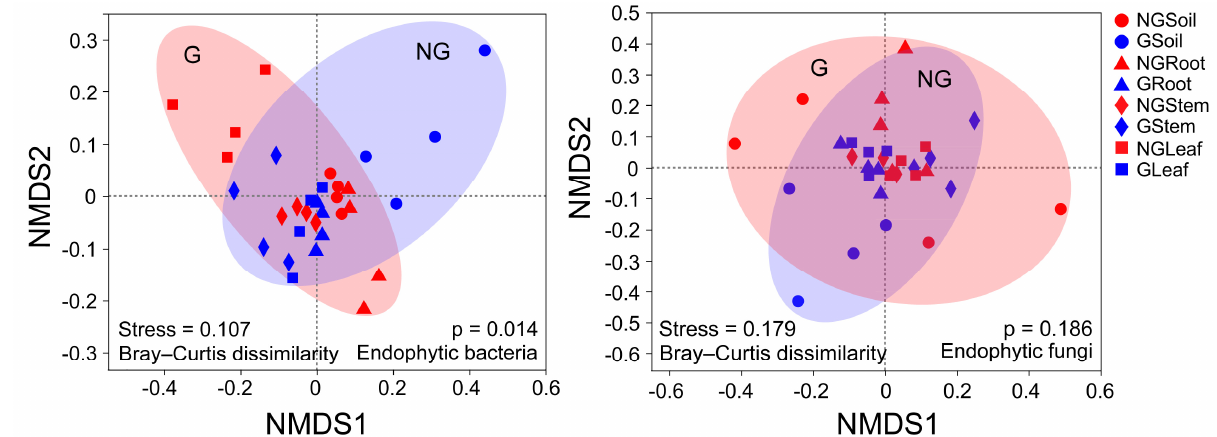
Figure 4. Non-metric multidimensional scaling (NMDS) evaluating differences in the endophytic bacterial community and endophytic fungal community between different tissues of Leymus chinensis grown in non-grazed and grazed grasslands. The distance between the samples was calculated based on dissimilarity in OTU composition using the Bray–Curtis dissimilarity index. Points of different shapes represent different samples, and a greater distance between two points represents a higher dissimilarity between them. NG: non-grazed grassland; G: grazed grassland.